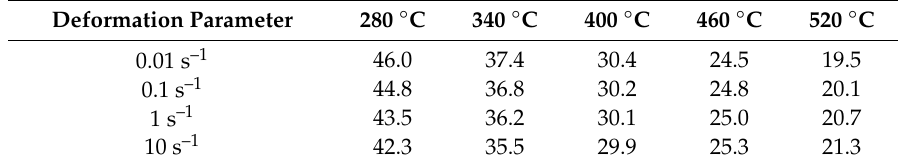
Table 4. The lnZ of Al–4.8Mg alloy under various deformation conditions calculated by various Q. Deformation